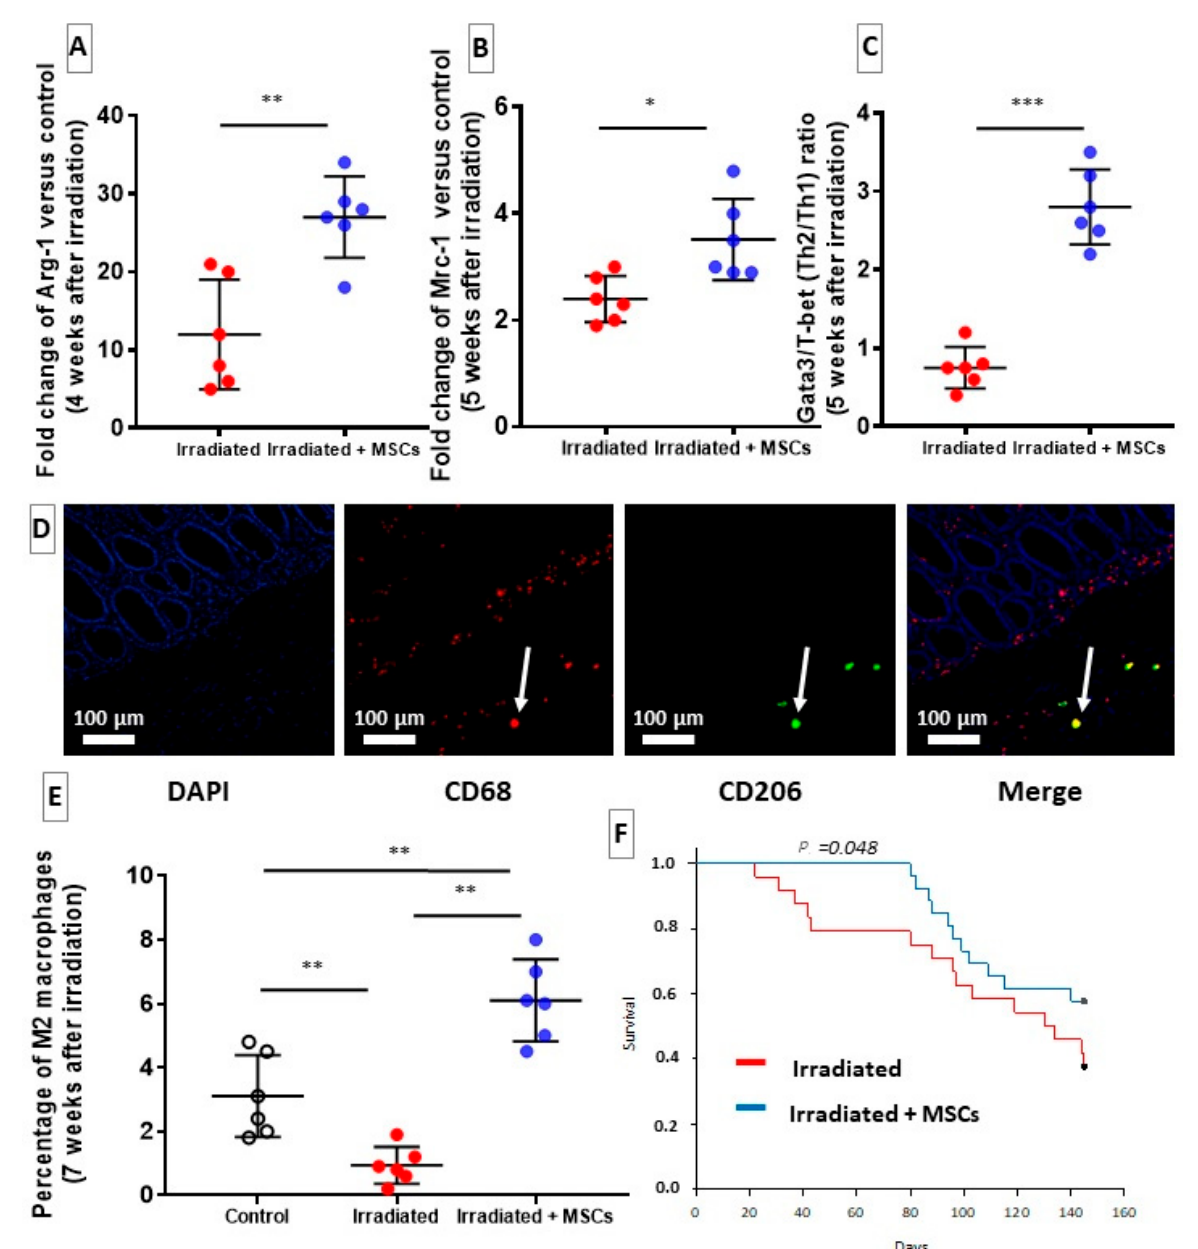
Figure 5. Effect of MSC transplantation on macrophage polarization in irradiated colon–rectum area. ( A , B ) mRNA fold changes of M2 markers Arginase-1 and Mannose Receptor-1 that are normalized to Ywhaz and standardized against control. ( C ) MSCs inverted Th2/Th1 balance in favor of Th2 cells 5 weeks after irradiation, as shown by increased Gata3/T-bet ratio gene expression. ( D ) M2 polarization was identified by co-staining paraffin-embedded tissue slides with 4 ′ ,6-dia- midino-2-phenylindole (DAPI) (cell nuclei, blue), CD68 antibody (red) and CD206 antibody (green). M2 macrophages are shown in yellow (merge) (original magnification: 100×). MSC injection induced a strong M2 polarization of macrophages 4 weeks after irradiation. ( E ) MSCs favor M2 polarization compared to control and Irradiated group. ( F ) Survival curve of Irradiated group (red line, n = 24) and Irradiated + MSCs group (blue line, n = 26). Risk comparison analysis showed a significant increase in survival after MSC transplantation ( p = 0.048). Each group of animals was composed of 6 rats. Results of each group were compared as follows: Irradiated group was compared to Control group; Irradiated + MSCs group was compared to control and Irradiated group. Two-group comparisons were performed with t -tests, while one-way ANOVAs, followed by Bonferroni t -tests, were used for multiple group comparisons. Survival curves were compared with the log-rank test. The results are expressed as mean ± SD. *: p < 0.05; **: p < 0.01; ***: p ≤